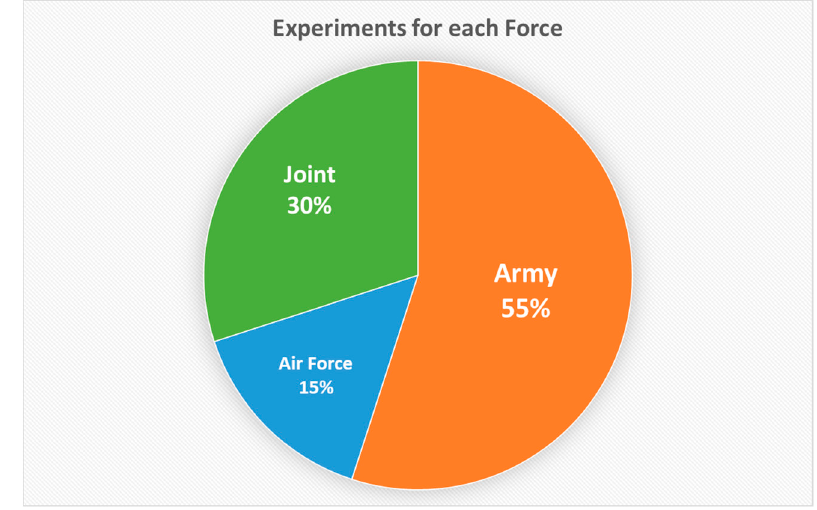
Figure 4. Comparing the experiments for each force.